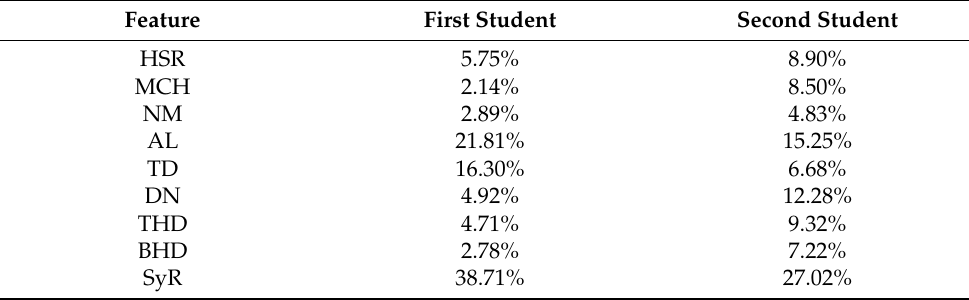
Table 9. Proportion of importance of the truss features.